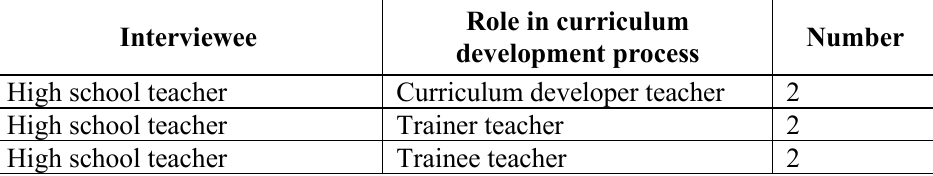
TABLE 1. INTERVIEWEES BY